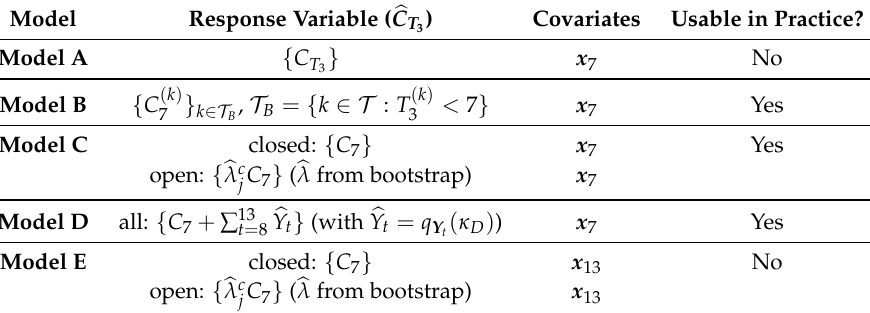
Table 1. Main specifications of XGBoost